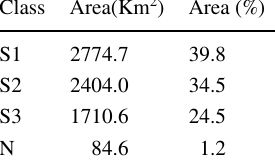
Table 13 Land suitability for surface irrigation, fuzzy membership values, and areal extent in Guder